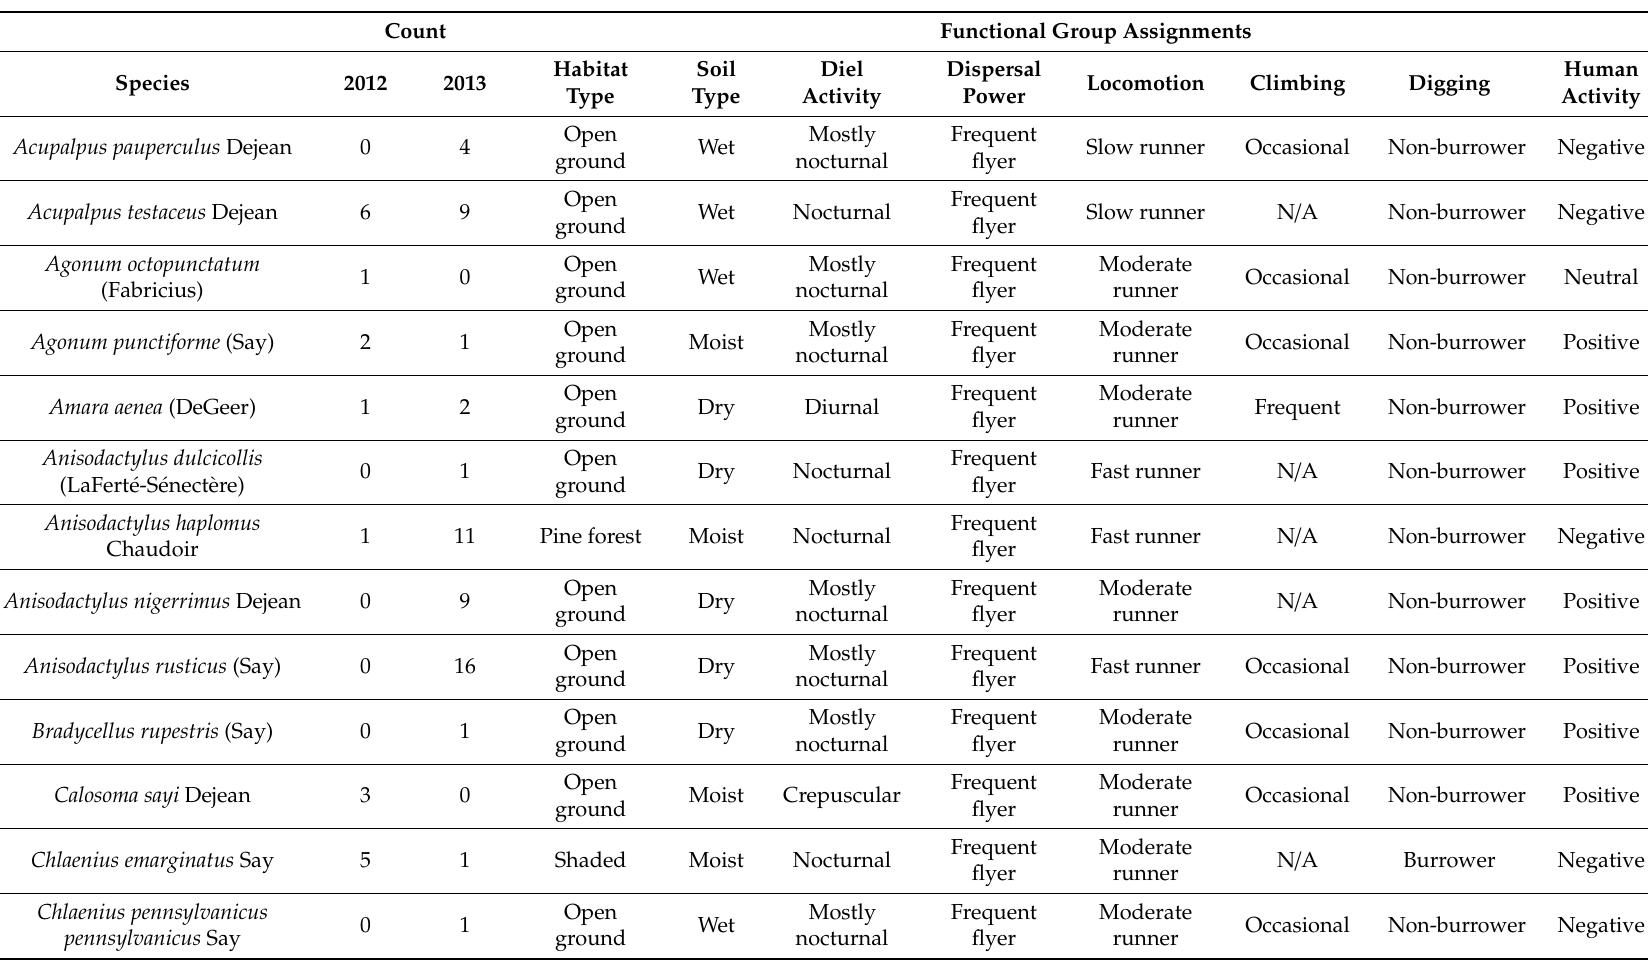
Table 1. Count and functional group assignments of ground beetles ( n = 480) captured in clear-cut stands within intensively managed pine plantations, North Carolina, 2012 and 2013. We assigned functional groups to each species per accounts in Larochelle and Lariviere